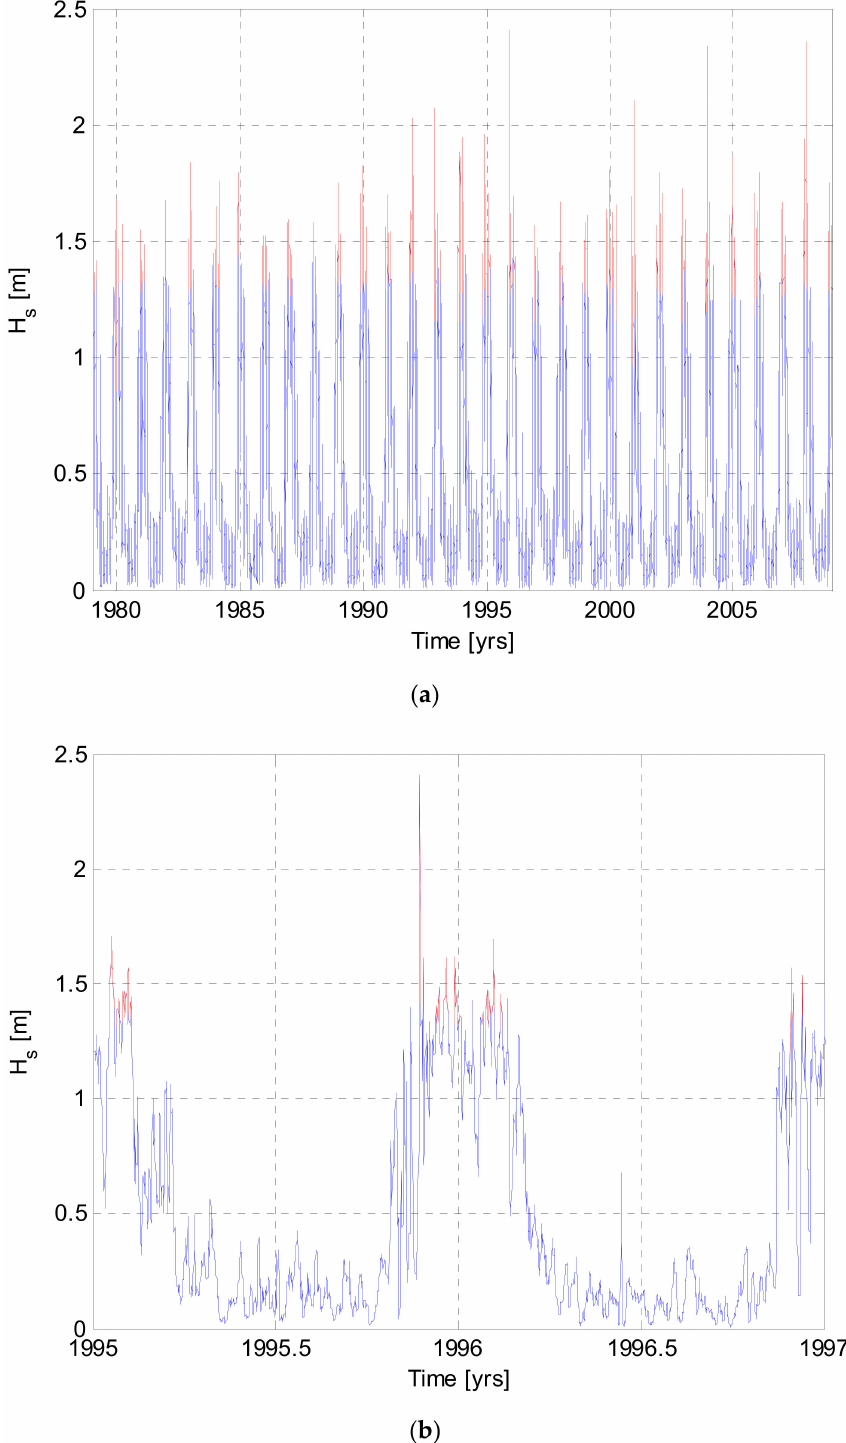
Figure 7. The process of storm detection for the data point in front of Dutch Bay. Storms identified over the 30-year period from 1979–2009 ( a ), zoom-in plot of storms identified over the 2-year period 1995–1997 ( b ); Blue: All data, Red: identified storm